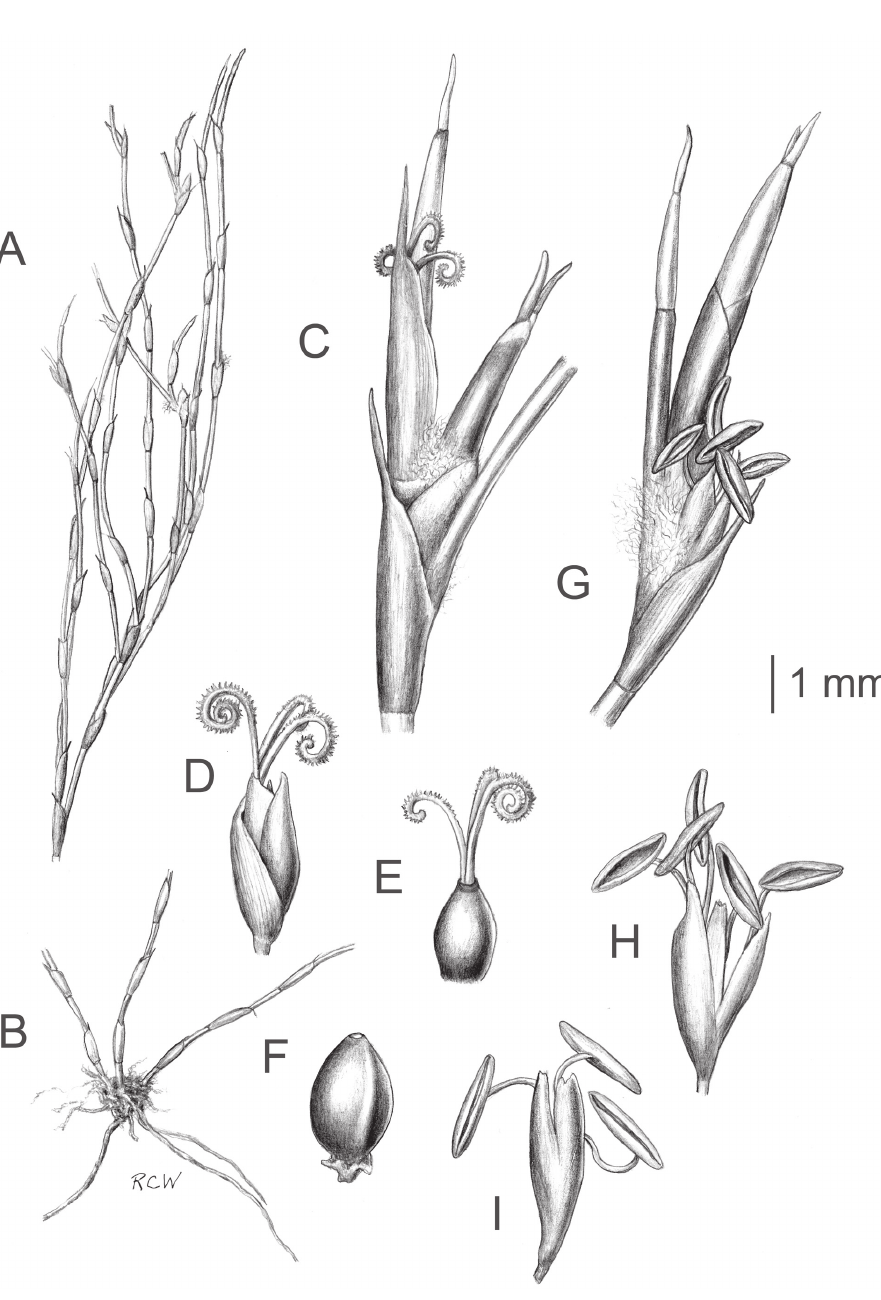
Figure 11. Morphological characteristics of Empodisma minus . A Vegetative shoot with attached leaves and flowers (2.5× actual size) B Rhizomes with emerging vegetative shoots (2.5× actual size) C Vegetative shoot with attached pistillate flower D Pistillate flower with attached bracts e Gynoecium F Mature nut G Vegetative shoot with attached staminate spikelet h Staminate flower with attached bracts i Staminate flower. Scale bar = 1